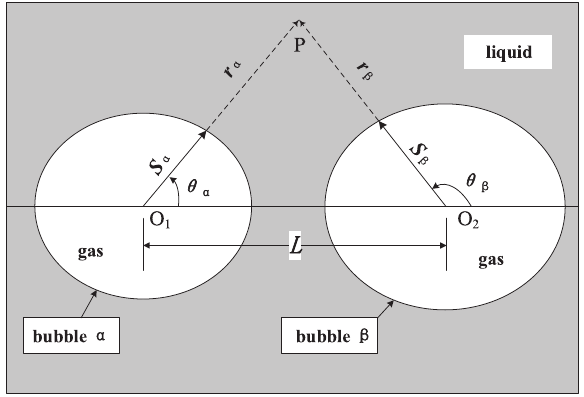
Figure 1. Sections of two nonspherical